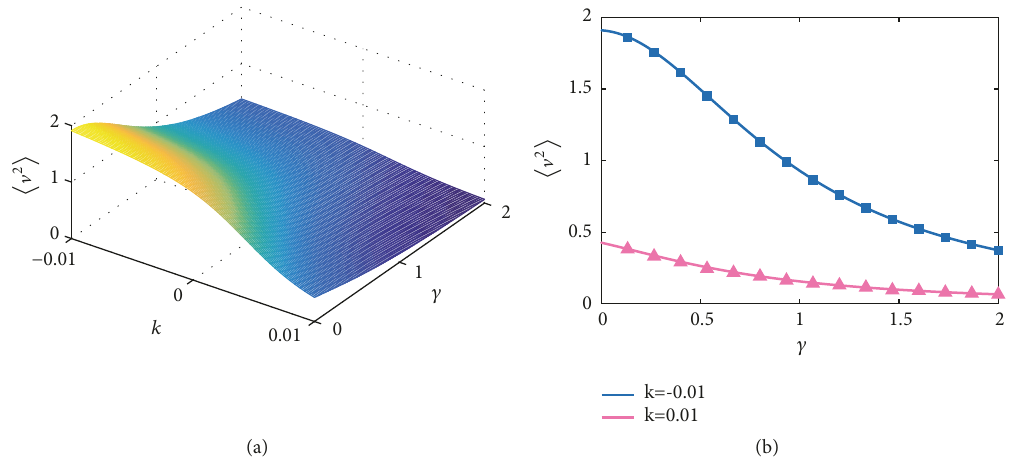
Figure 11: The dependence of the mean square electric voltage ⟨ V 2 ⟩ on 𝑘 and 𝛾 . Solid lines are the analytical results; symbols result from numerical